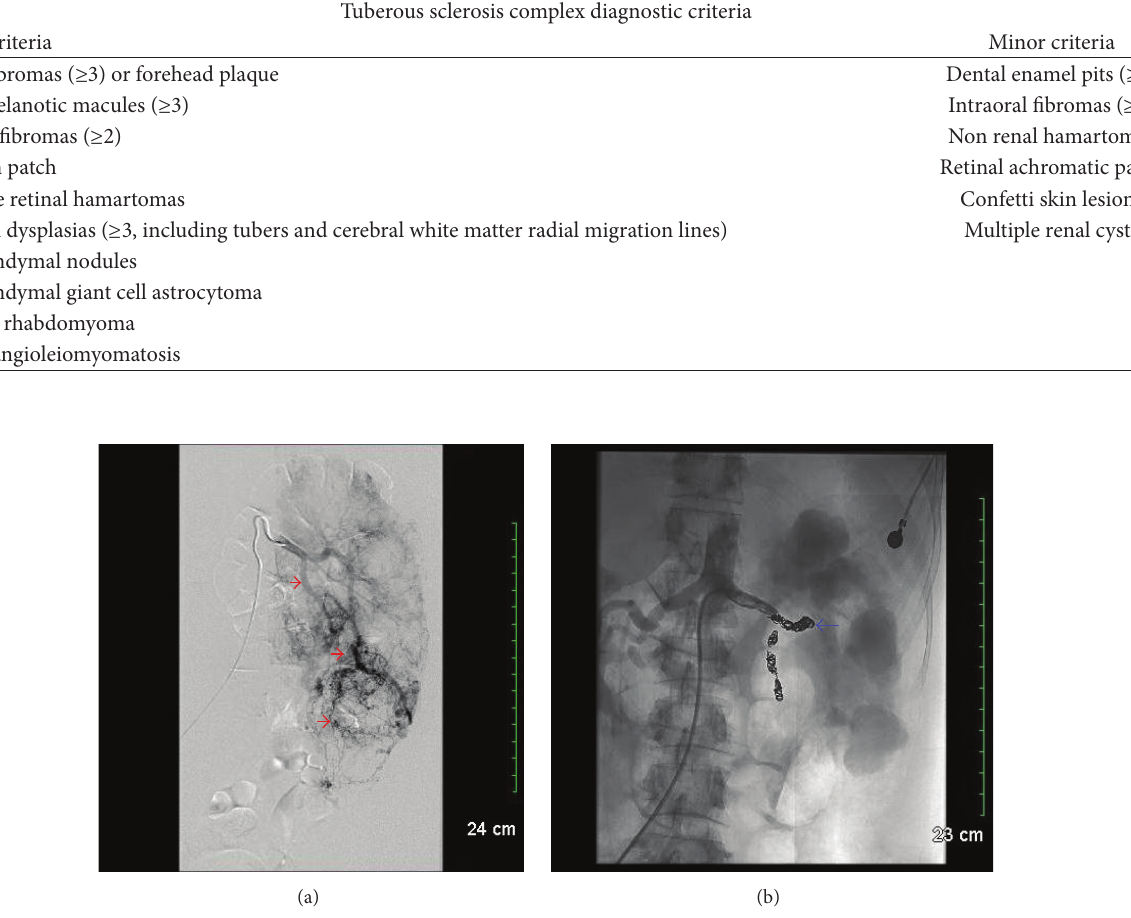
Figure 2: (a) Image of left renal arteriography prior to embolization that showed enlarged kidney with extensive tumor vasculature. Red arrows demonstrate renal vasculature as seen on arteriography. (b) Image after left renal embolization with visualization of metallic coils. Blue arrow indicates metallic coil.